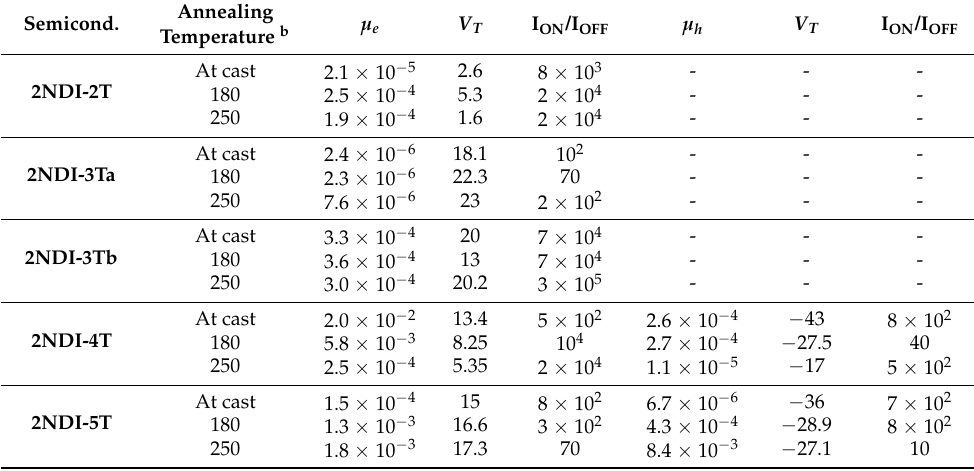
Table 4. OFET electrical data for vapor-deposited films of 2 NDI-nT semiconductors measured under vacuum a .